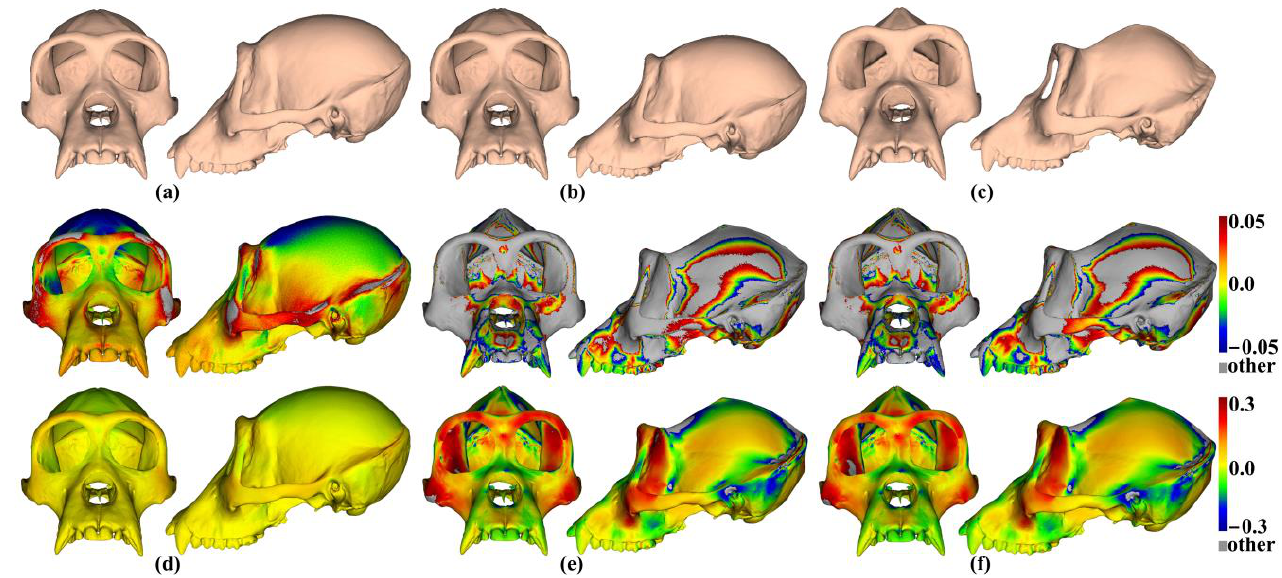
Figure 24. Top row: ( a ) Mean ape cranial surface estimated by warping the template surface to the mean configuration of landmarks and 1000 semilandmarks from sliding TPS. ( b ) Mean ape cranial surface estimated by warping the template surface to the mean landmark configuration. ( c ) Mean ape cranial surface estimated by warping the surface of the cranium used to generate the template to the mean landmark configuration. Colour maps between the surfaces using different colour ranges (see text) in the middle row and bottom rows: ( d ) Colour map between surfaces a (reference) and b (target). ( e ) Colour map between surfaces a (reference) and c (target). ( f ) Colour maps between surfaces b (reference) and c (target).